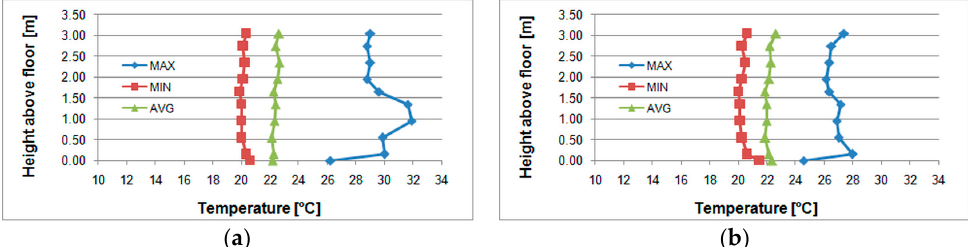
Figure 7. Vertical profile of internal air temperature: ( a ) during the whole measurement period; ( b ) during the transitional week.